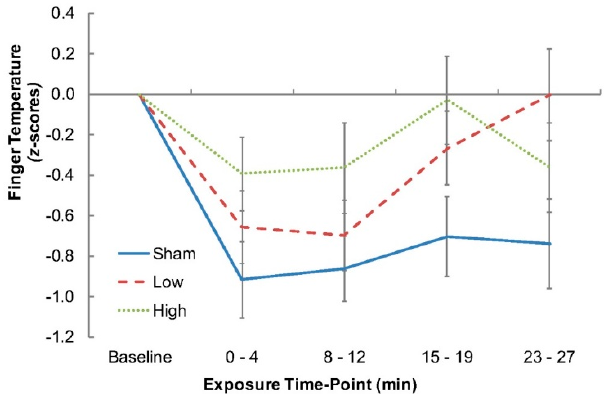
Figure 3. Mean change in finger temperature from Baseline to the end of exposure for the Sham, Low, and High exposure conditions (error bars denote standard errors of the means).